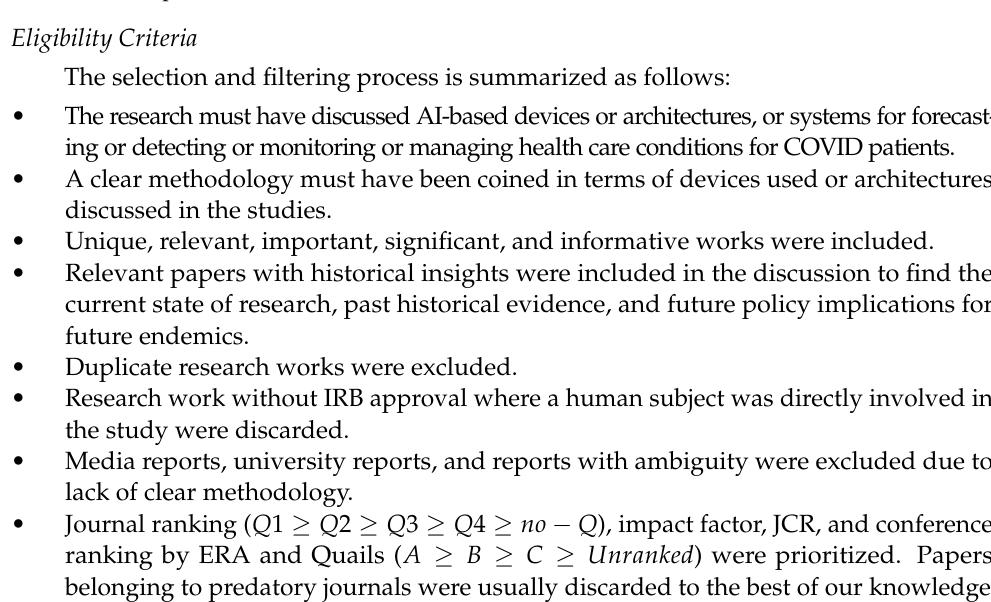
Figure 2. Overview of papers selected from different databases. ( a ) The bar plot illustrates the numbers of papers selected from Nature, IEEE, Springer, Elsevier, MDPI, PLOS, Wily, Frontiers, and others. ( b ) The pie chart shows the distribution of selected articles and